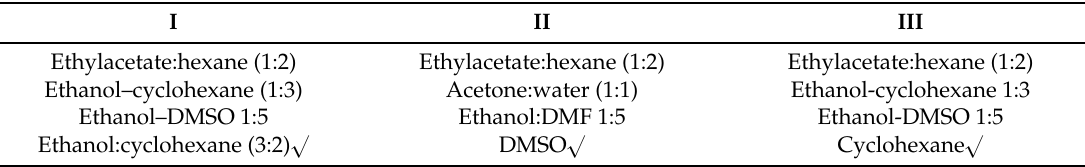
Table 6. Solvent conditions tested to obtain tiny